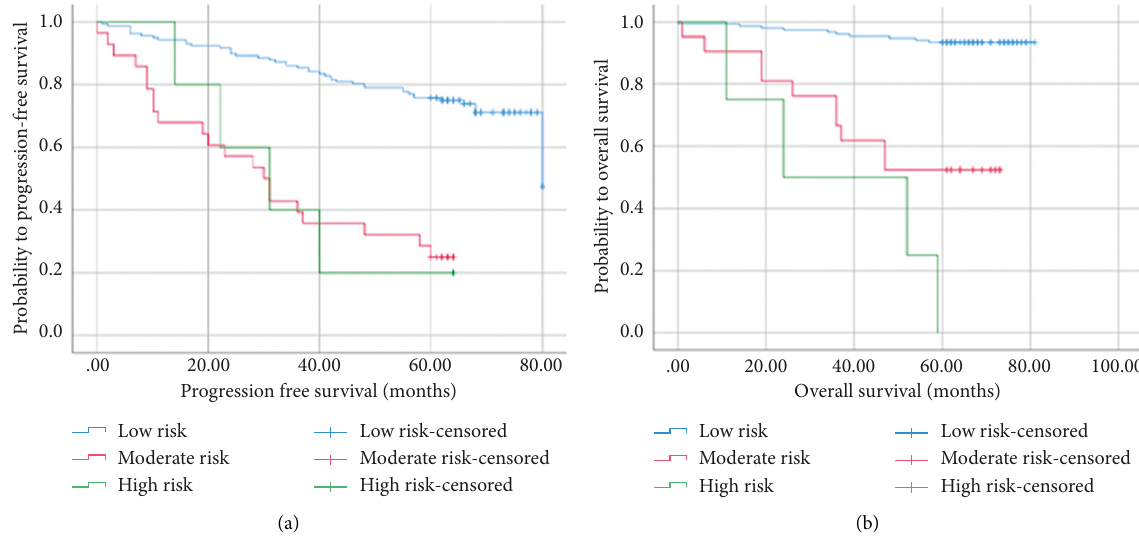
Figure 4: Kaplan–Meier curves for progression-free survival (a) and overall survival (b) probability according to the risk